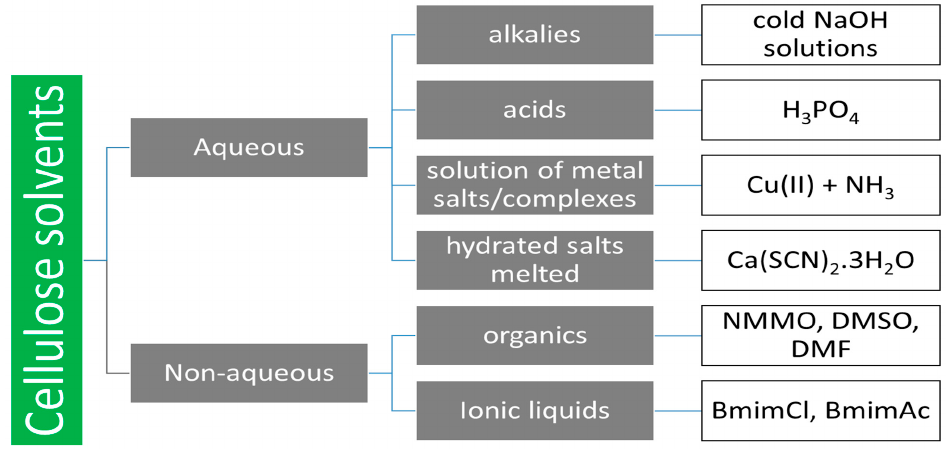
Figure 4. Cellulose solvents.